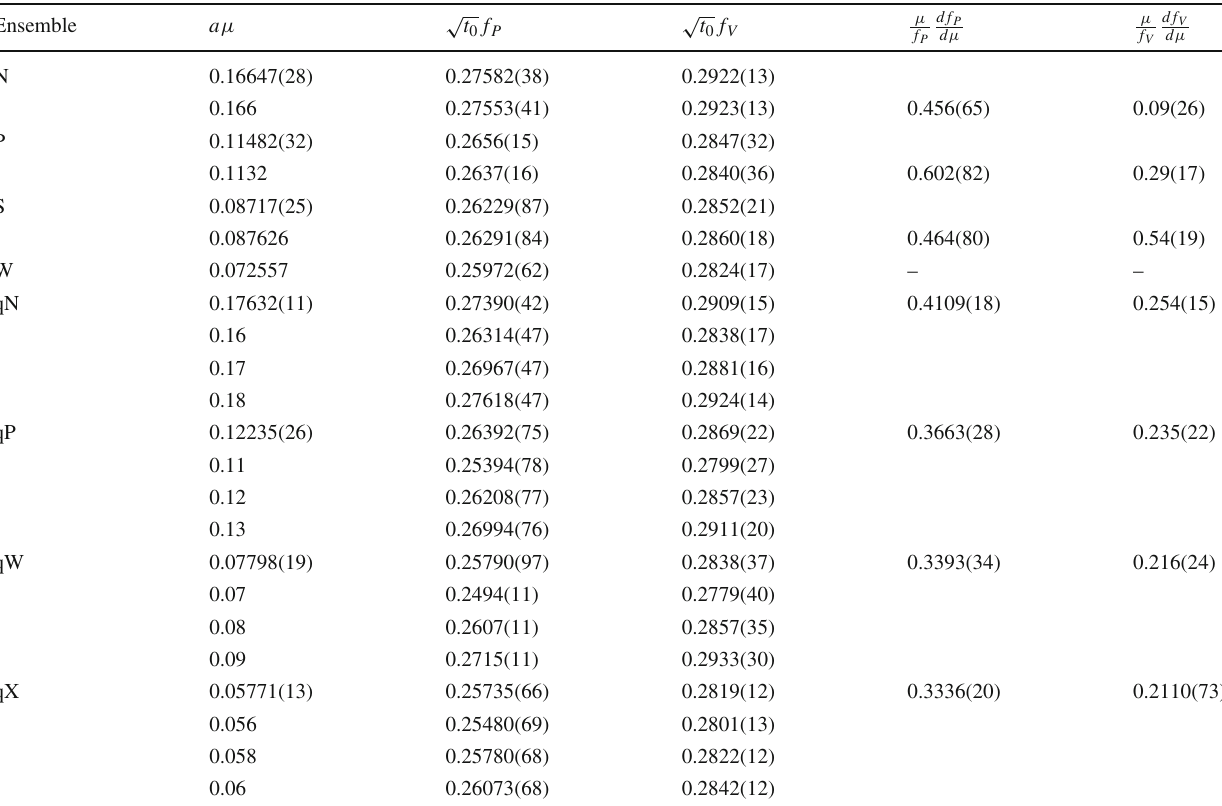
following three lines contain the values measured at different valence quark masses. The last two columns are the values of the logarithmic derivatives of the decay constants with respect to the logarithm of the quark mass. For the ensemble W they have not been